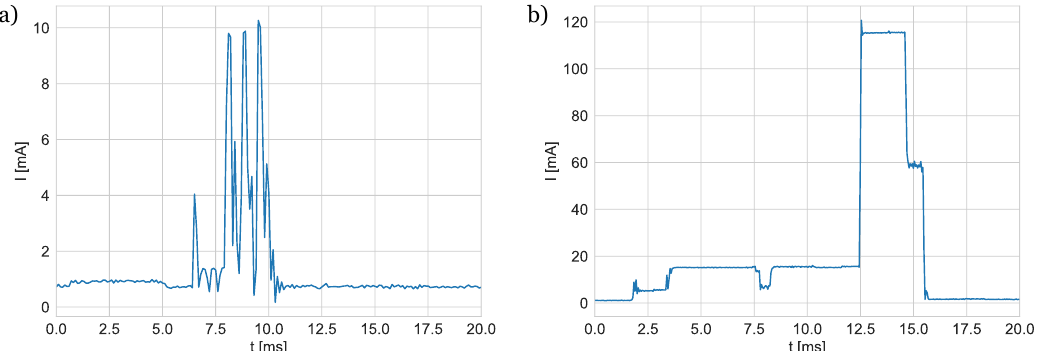
Figure 15. Current consumption during sending of ( a ) a Bluetooth Low Energy (BLE) packet and ( b ) a UWB packet.